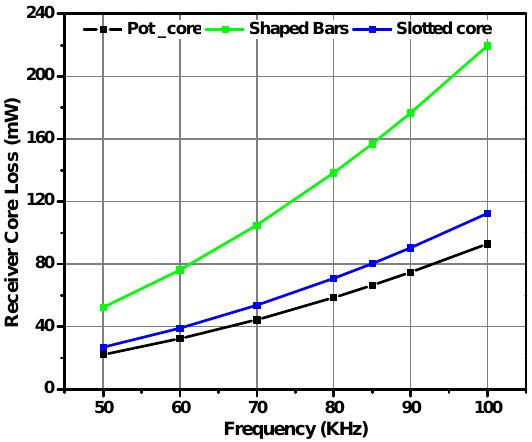
Figure 10. The Rx core loss vs. the frequency for the proposed